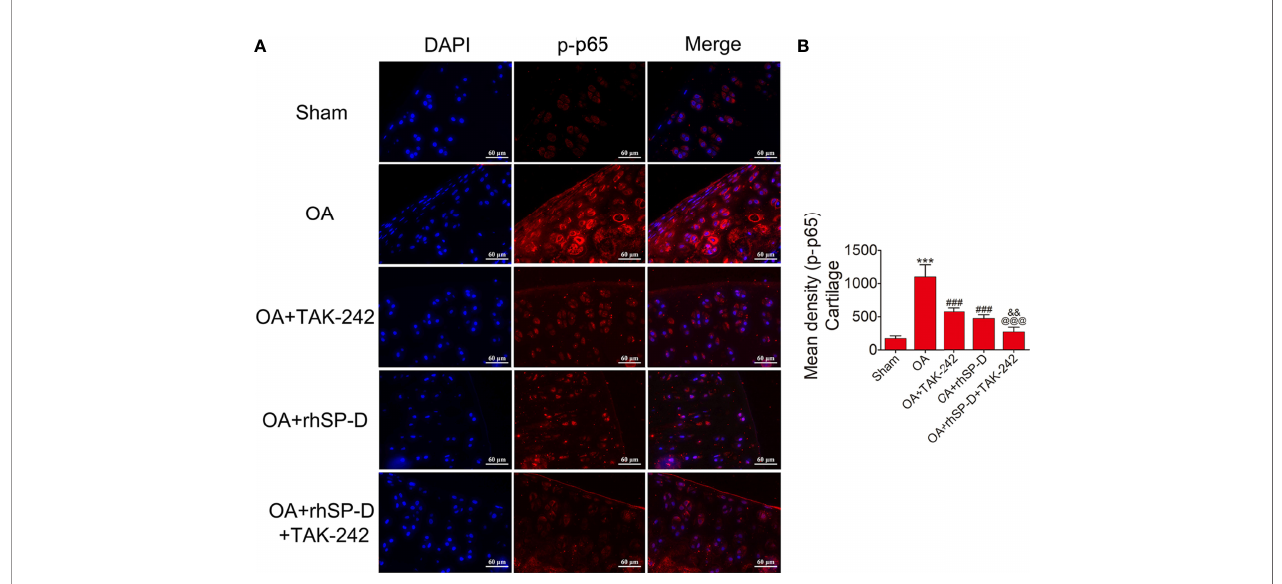
FIGURE 7 | SP-D regulated TLR4-mediated NF- k B pathway in vivo . (A) Immuno fl uorescence with an antibody to p-p65 in articular cartilage from the ACLT + MMx- induced OA rats with rhSP-D and TAK-242 treatment at 10 weeks post-surgery. (B) The ratios of immunoreactive cells were quanti fi ed in articular cartilage according to immuno fl uorescence. Data were expressed as mean ± SEM (n = 5). ***P < 0.001 vs. the sham-operated group; ### P < 0.001 vs. the OA-induction group; && P < 0.01 vs. OA + rhSP-D group; @@@ P < 0.001 vs. OA + TAK-242 group. knockdown by rAAV injection resulted in the induction of TLR4-mediated PI3K/Akt transcription and NF- k B activation. in fl ammatory and innate responses in joint cartilage; however, Firstly, transcriptome analysis revealed that SP-D overexpression these responses were not suf fi cient to promote disease broadly affects in fl ammatory response, immune response, and progression. Finally, SP-D binds to TLR4/MD-2 complex to PI3K-Akt and TLR signaling in chondrocytes. Secondly, SP-D